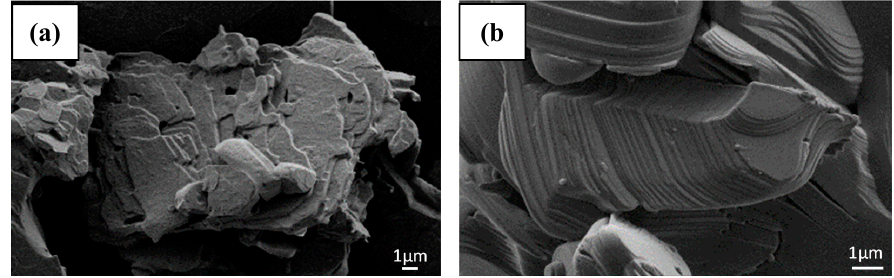
Figure 3. FESEM images of MA 2 CuCl 2 Br 2 . Powder sample 4000x (a) and film sample 8000x (b).